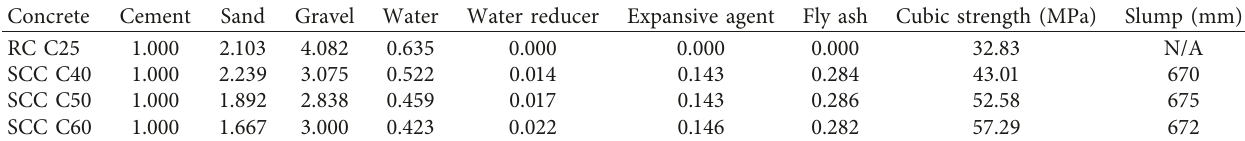
Table 2: Mixes and properties of concrete.